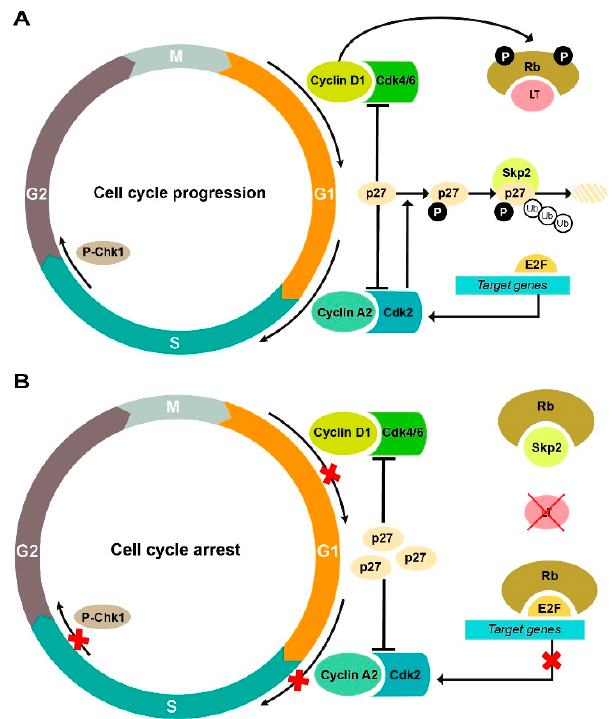
Figure 7. Schema of cell cycle regulation by MCPyV LT. ( A ) When MCPyV LT is present, high levels of cyclins and cyclin-dependent kinases promote cell cycle progression and Rb-phosphorylation. Cdk2 also phosphorylates the negative regulator p27, which is recognized by Skp2 for subsequent degradation; ( B ) Upon CRISPR/Cas9 editing of MCPyV LT, the Rb protein can repress the expression of the E2F target genes, contributing to cell cycle arrest. It can also interact with Skp2, promoting the accumulation of p27 to inhibit cell cycle progression.